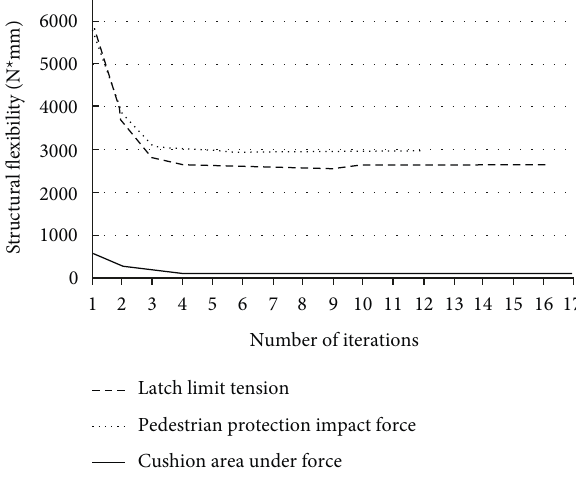
Figure 5: Static load topology optimization iteration